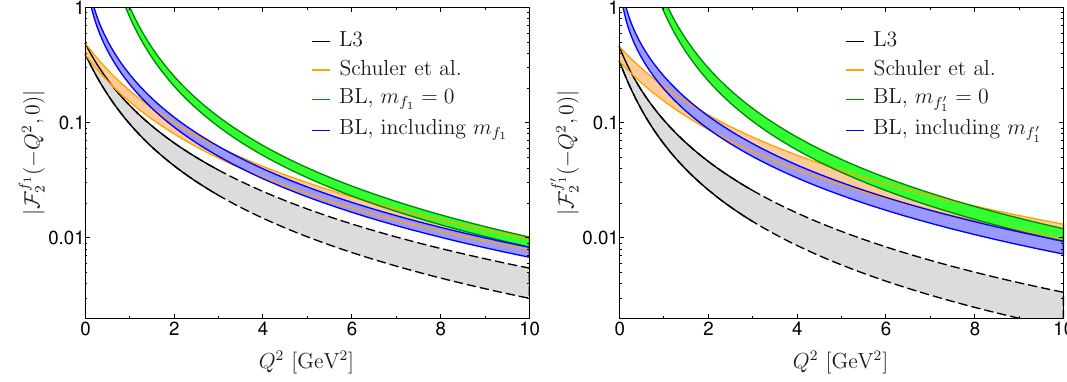
A Figure 2 . Axial-vector TFF for f 1 (1285) (left) and f 0 (1420) (right). In each case, the gray band 2 1 F refers to the dipole (cid:12)t (4.1) with parameters (4.2), the orange band to the quark model from [82], see (3.47) (with normalization adjusted to the L3 data), the green band to the asymptotic BL result (4.5), and the blue band to the variant including the axial-vector mass (4.6). The uncertainties are propagated from (4.2) and (4.12), respectively. The L3 dipole (cid:12)t is indicated by dashed lines above 3 GeV 2 (close to the center of the last bin), to emphasize the fact that only a single bin probes the region above 1 GeV 2